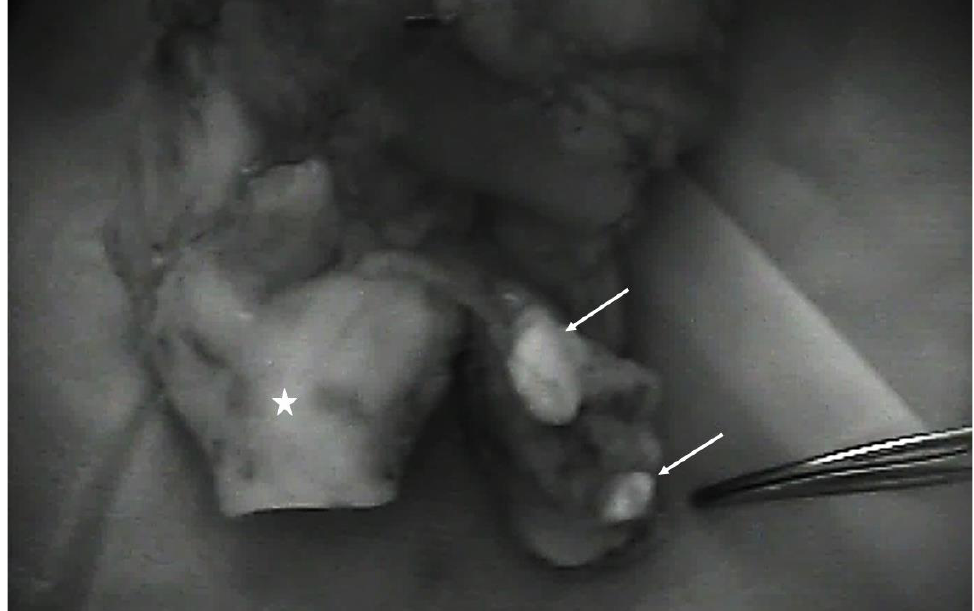
Figure 2. Posterior view of a total laryngectomy specimen (white star) seen with the near-infrared camera showing two autofluorescent parathyroids (white arrows).